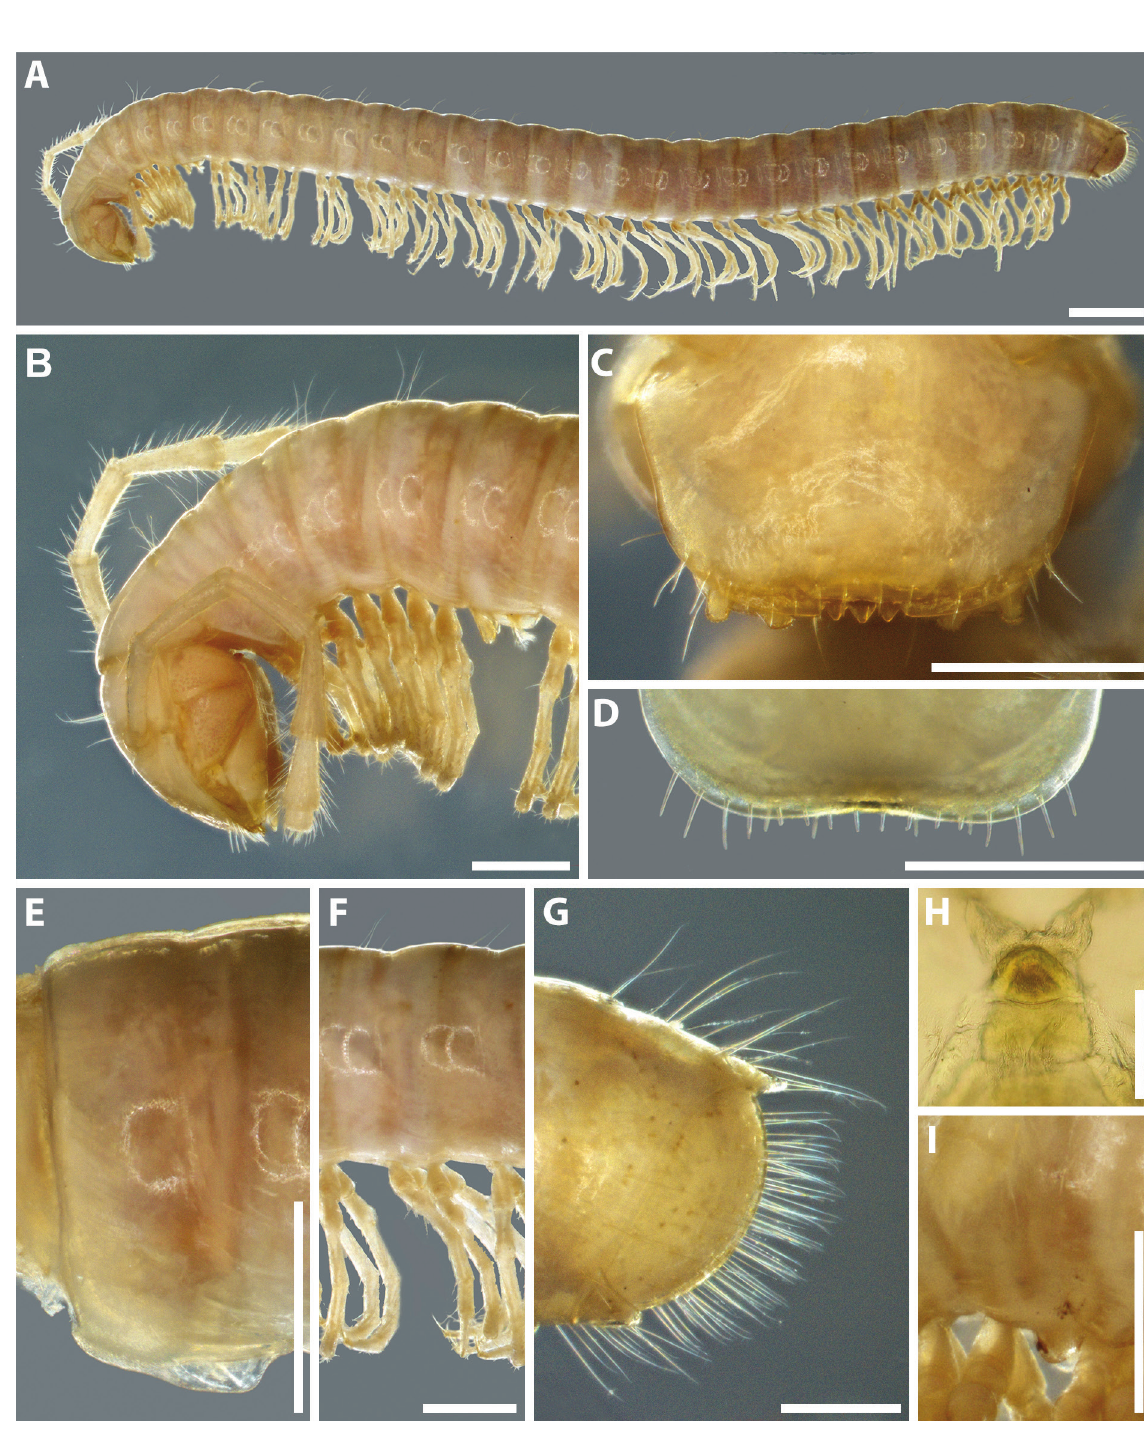
Fig. 1. Stygiiulus fimbriatus (Strasser, 1971) comb. et stat. nov., ♂♂ (A–H) and ♀ (I) from Foran di Landri Cave (IZB). A . Habitus, lateral view. B . Anterior part of body, lateral view. C . Labrum, fronto- dorsal view. D . Labrum, dorsal view. E . Pleurotergum 7, lateral view. F . Mid-body rings, lateral view. G . Telson, lateral view. H . Posterior node of hypopharynx, fronto-ventral view. I . Lobe of body ring 3, lateral view. Scale bars: A = 1 mm; B–G, I = 0.5 mm; H = 0.1